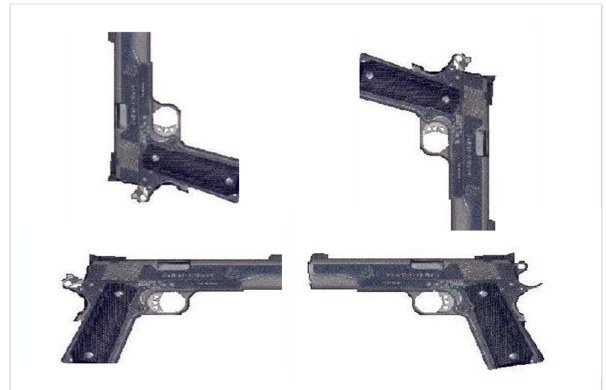
Figure 3. Image filtration using OpenCV filters; top left to bottom right ( a – d ): ( a ) actual image, ( b ) equalized filter result, ( c ) gray scale filter result, and ( d ) CLAHE filter result.